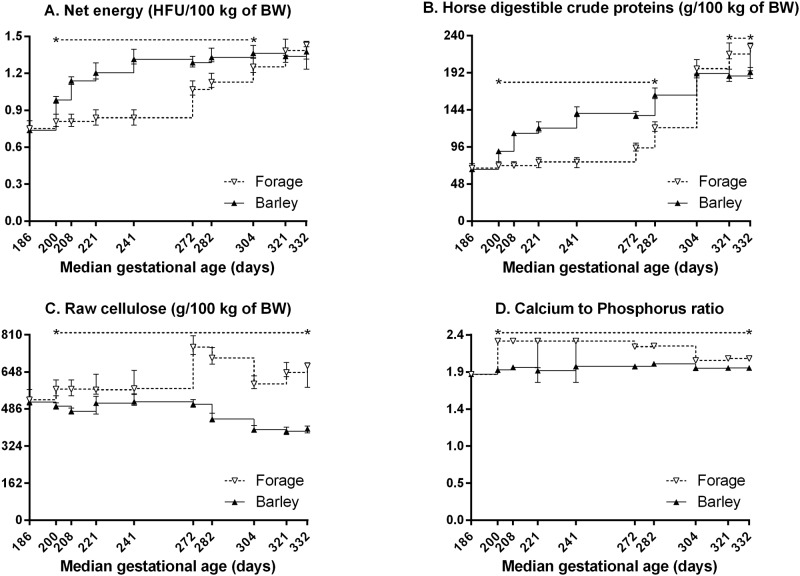
Daily nutritional offer (median and IQR) to broodmares in late pregnancy: net energy (A), horse digestible crude proteins (B), raw cellulose (C), and calcium to phosphorus ratio (D).HFU: horse feed units, BW: bodyweight. Values under the asterisks significantly differ between groups (Mann-Whitney test with FDR adjustment).